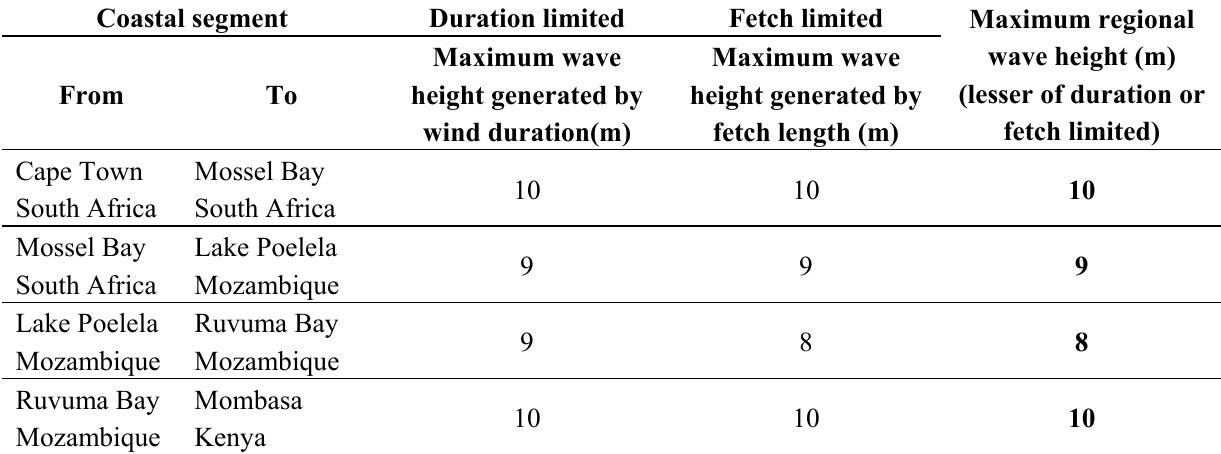
Table 2. Potential maximum wave heights in the region calculated using the US Corps of Engineers Coastal Engineering Manual [38]. Coastal segment Duration limited Fetch limited Maximum regional wave height (m) Maximum wave Maximum wave (lesser of duration or From To height generated by height generated by fetch limited) wind duration(m) fetch length